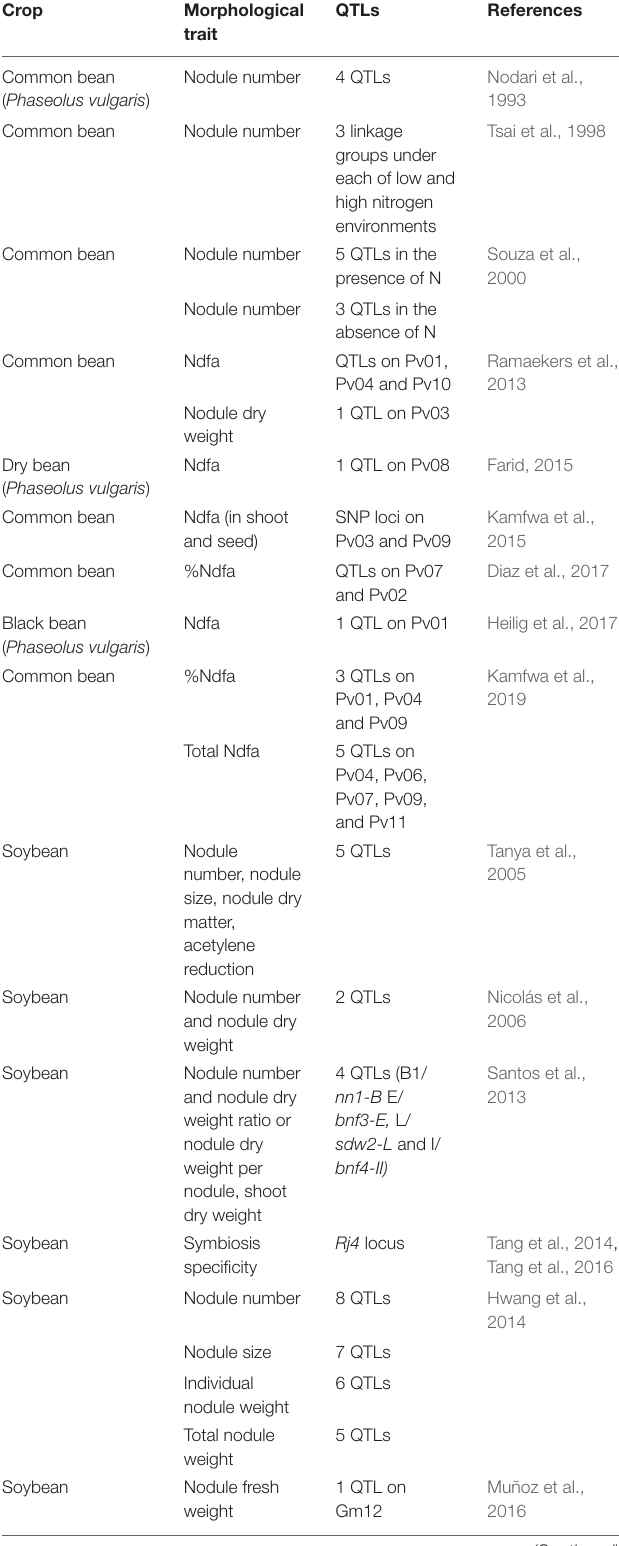
TABLE 1 | QTLs and SNP loci information for the morphological traits associated with